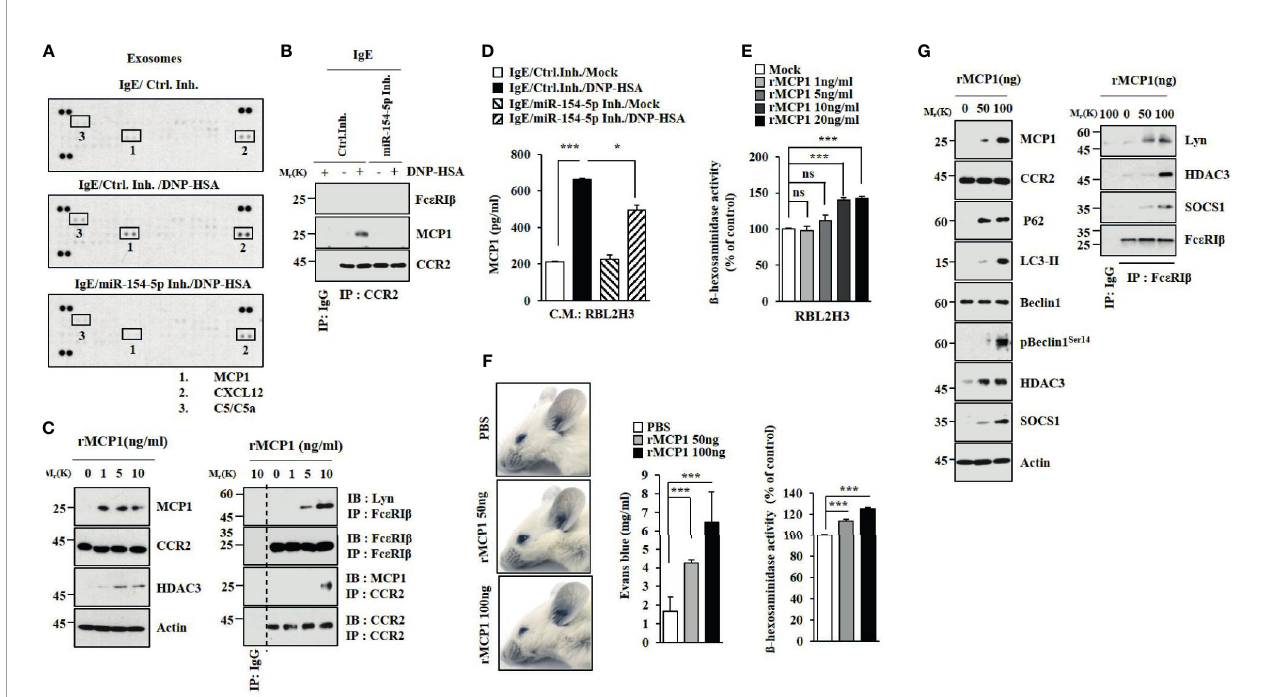
FIGURE 4 | MCP1 regulated by miR-154-5p induces molecular features of anaphylaxis. (A) . At 24 h after transfection with the indicated inhibitor (each at 10 nM), cells were sensitized with DNP-speci fi c IgE for 24 h followed by stimulation with DNP-HSA for 1 h. Exosomes isolated from culture medium were subjected to cytokine array analysis. (B) Cell lysates were subjected to immunoprecipitation. Representative blots of three independent experiments are shown. (C) RBL2H3 cells were treated various concentrations of mouse recombinant MCP1 protein for 1 h. Representative blots of three independent experiments are shown. (D) Same as (B) except that ELISA was performed employing culture medium. * p <0.05; *** p <0.001. Average values of three independent experiments are shown. (E) RBL2H3 cells were treated with various concentrations of MCP1 protein (rMCP1) for 1 h followed by b -hexosaminidase activity assays (right). *** p <0.001. Average values of three independent experiments are shown. (F) BALB/C moues was given an intradermal injection of rMCP1 protein at the indicated concentration along with 2% (v/v) Evans blue solution. The b -hexosaminidase activity assays employing ear tissue lysates were performed. (lower). *** p <0.001. Average values of three independent experiments are shown. (G) Immunoblot and immunoprecipitation were performed. Representative blots of three independent experiments are shown. NS, not signi fi